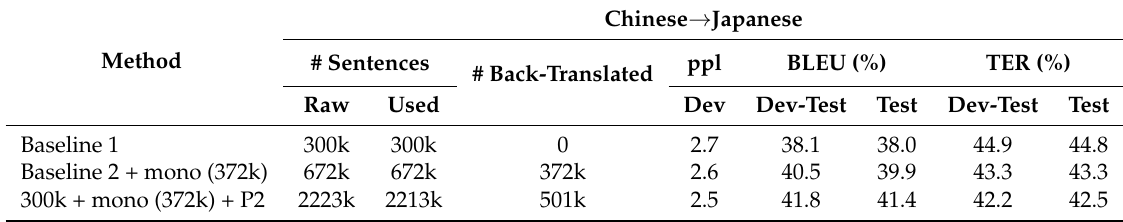
Table 9. Experiment results of Chinese → Japanese MT with 300k sentences and 372k monolingual sentences. “ppl” denotes perplexity. “Dev” denotes development data. “Dev-test” denotes development-test